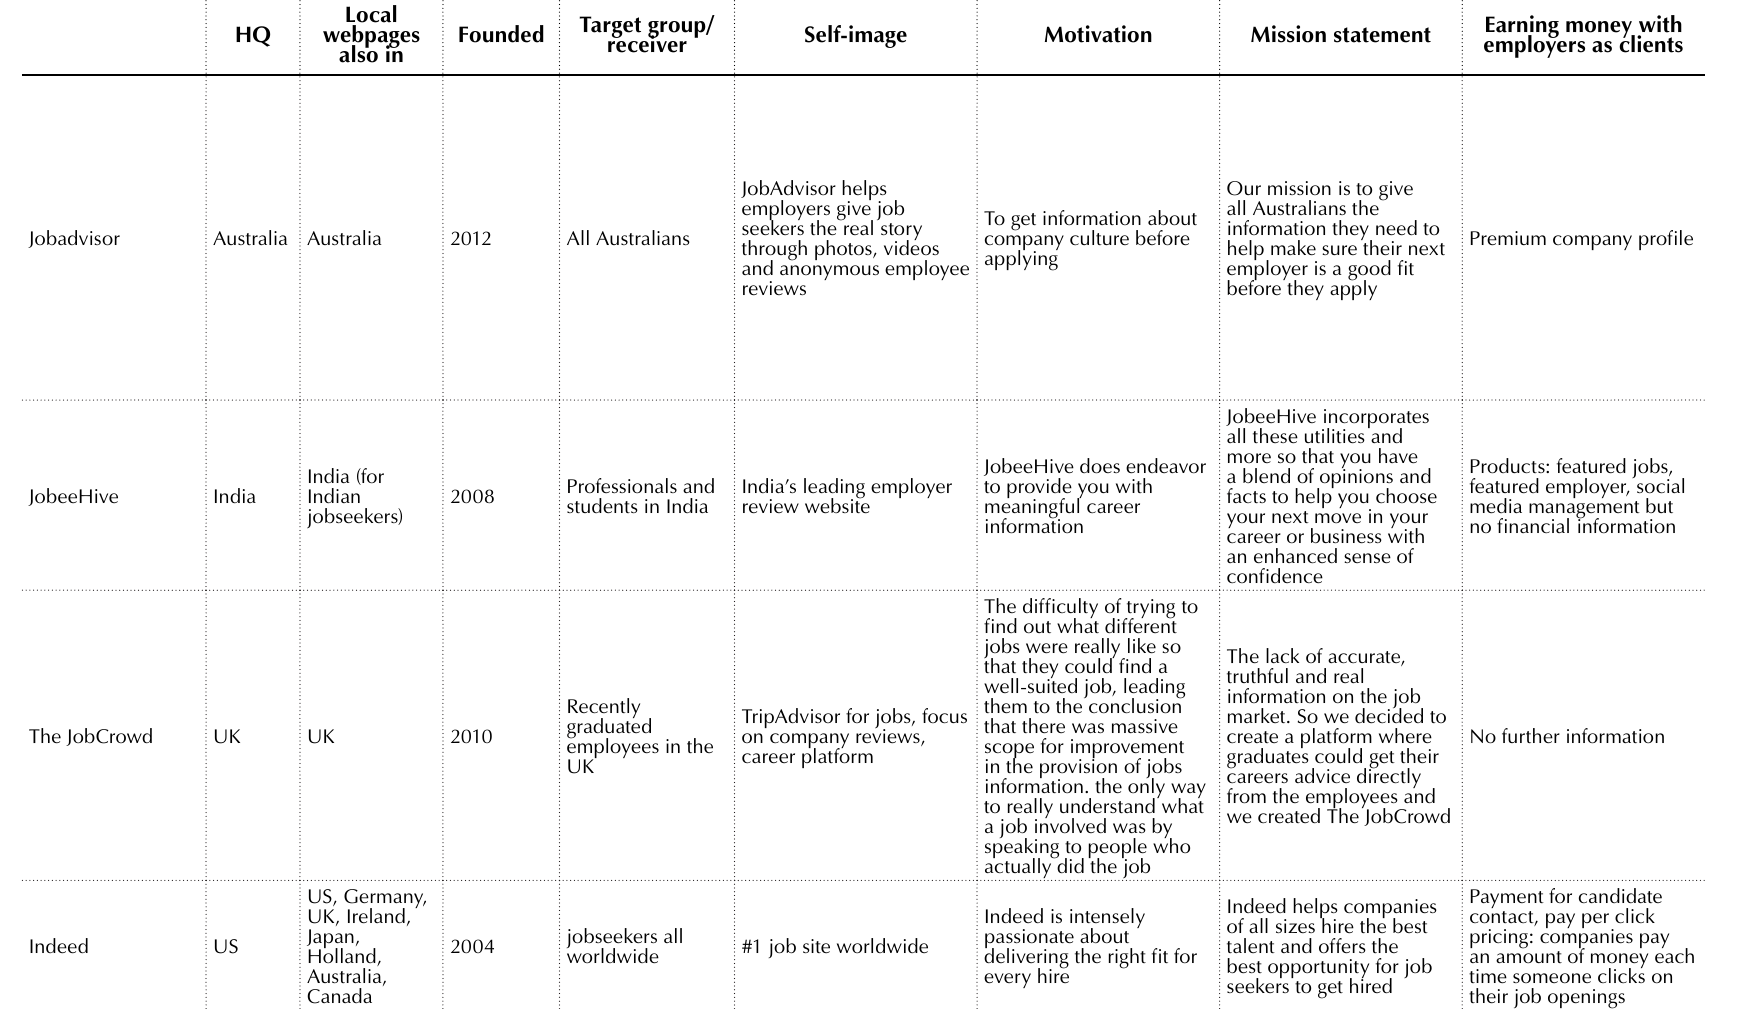
Table 1 (cont). Social Structure of Job Review